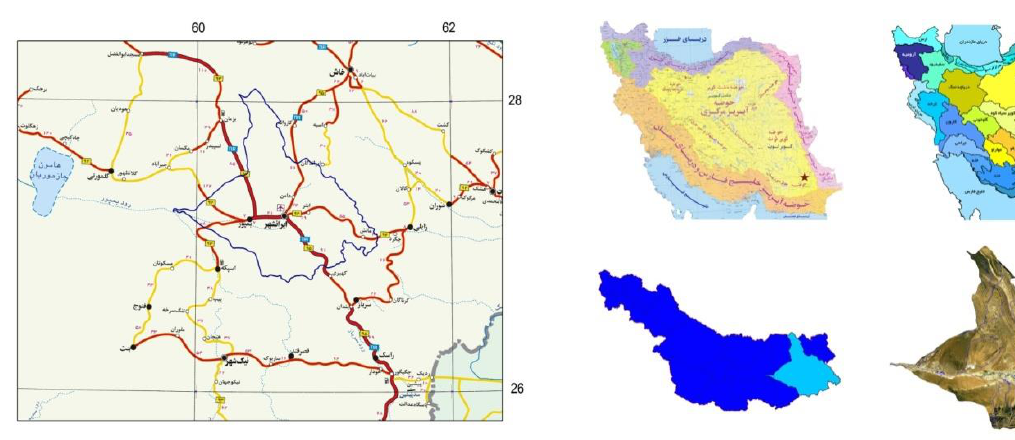
Figure 3. Access roads to different parts of Iranshahr catchment